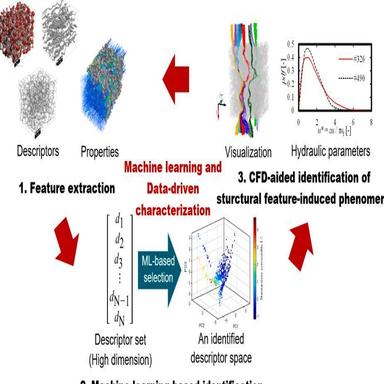
Concept of ML and data-driven characterization based on descriptor space.